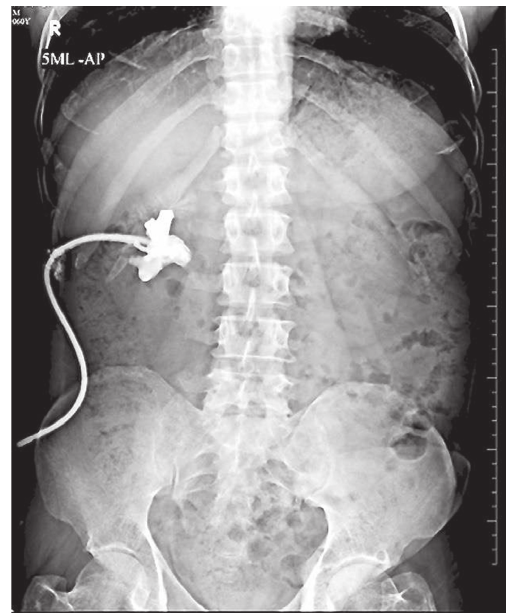
Figure 3: Complete (two-point) ureteral avulsions with percuta- neous nephrostomy (PCN) in situ. Nephrostogram showing blind- ending pelviureteric junction (PUJ).